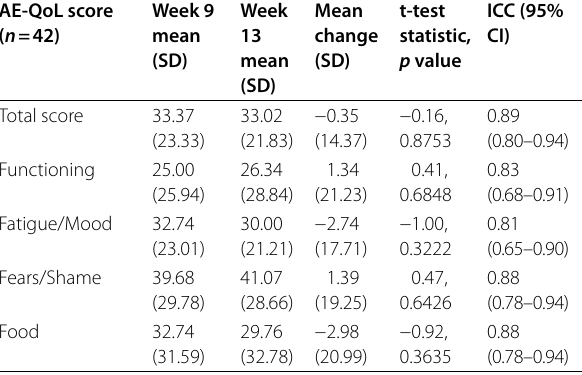
Table 4 Test-retest reliability of AE-QoL total and domain